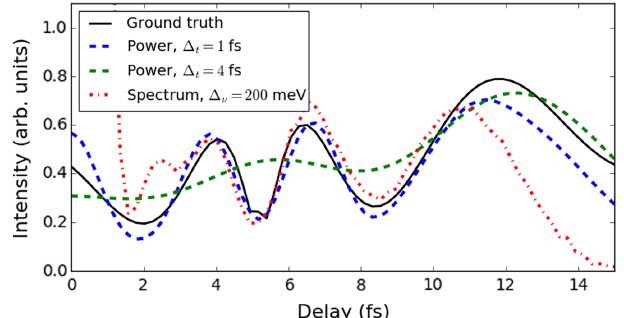
FIG. 3. Fluctuations in A ð f Þ and A are strongly correlated for ≪ τ < T , with pulse length T and coherence length delays t coh t . The figure shows the Pearson correlation between A ð f Þ and A coh for both an analytical model of Gaussian wave packets (solid blue line; see Ref. [41]) and 1D simulations of a presaturation FEL with the parameters in Table I (dashed red line).